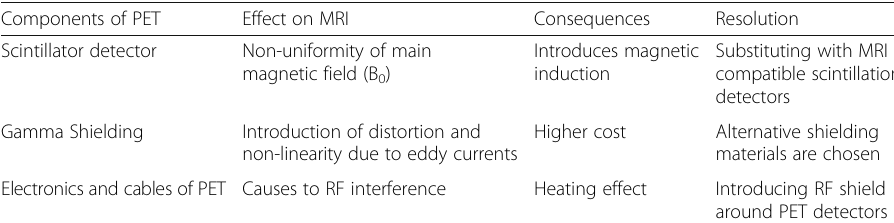
Table 2 PET system affecting MRI Components of